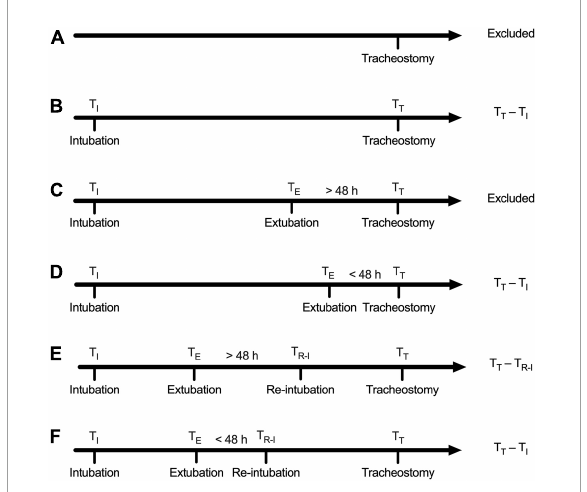
FIGURE1 Definition of tracheostomy timing. (A) Patients with no record of endotracheal intubation regardless of the record of extubation were excluded. (B) Cases with only one record of intubation and without the record of extubation: Tracheostomy timing was calculated as the time interval between intubation and tracheostomy. (C) Tracheostomy was performed beyond 48 h after extubation: Defined as successful extubation and excluded. (D) Tracheostomy was performed within 48 h after extubation, defined as extubation failure, and tracheostomy timing was calculated as the time interval between tracheostomy and intubation prior to failed extubation. (E) Reintubation was performed beyond 48 h after extubation, defined as successful extubation, and tracheostomy timing was calculated as the time interval between reintubation and tracheostomy. (F) Reintubation was performed within 48 h after extubation, defined as extubation failure, and tracheostomy timing was calculated as the time interval between the first intubation and the